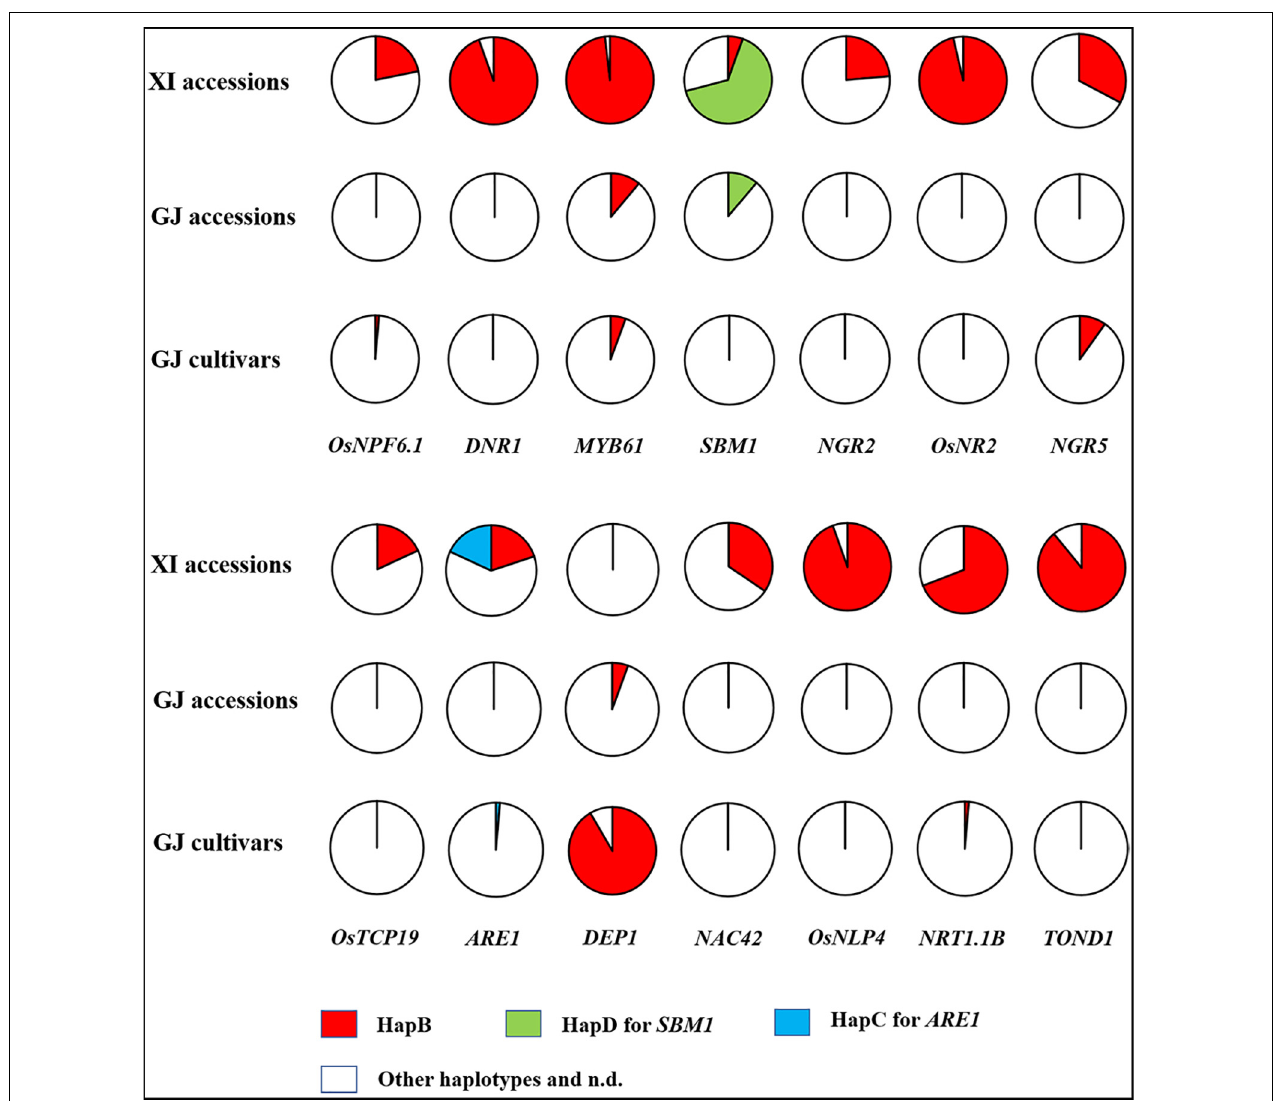
FIGURE 3 | Distribution of elite haplotypes of 14 NUE genes in 55 XI accessions, 18 GJ accessions, and 71 GJ